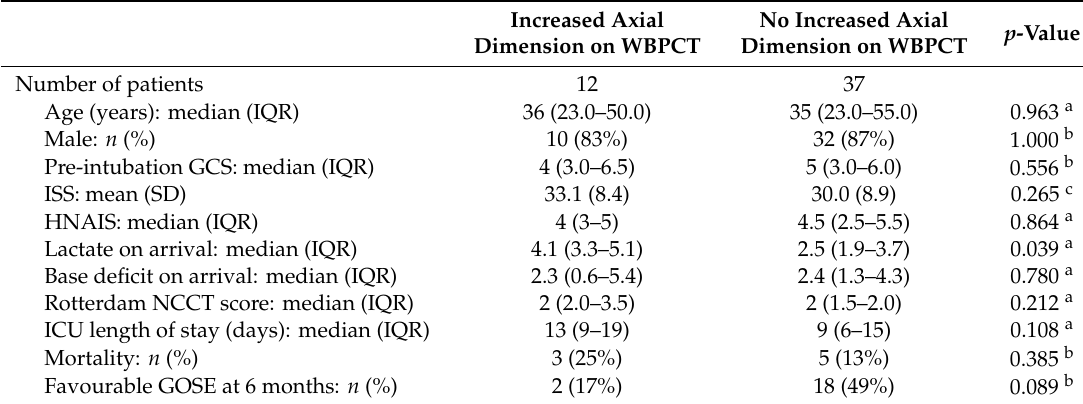
Table 5. Comparison of patients with increased axial dimension of perfusion abnormality detected by WBPCT versus those without any increase in abnormality’s axial